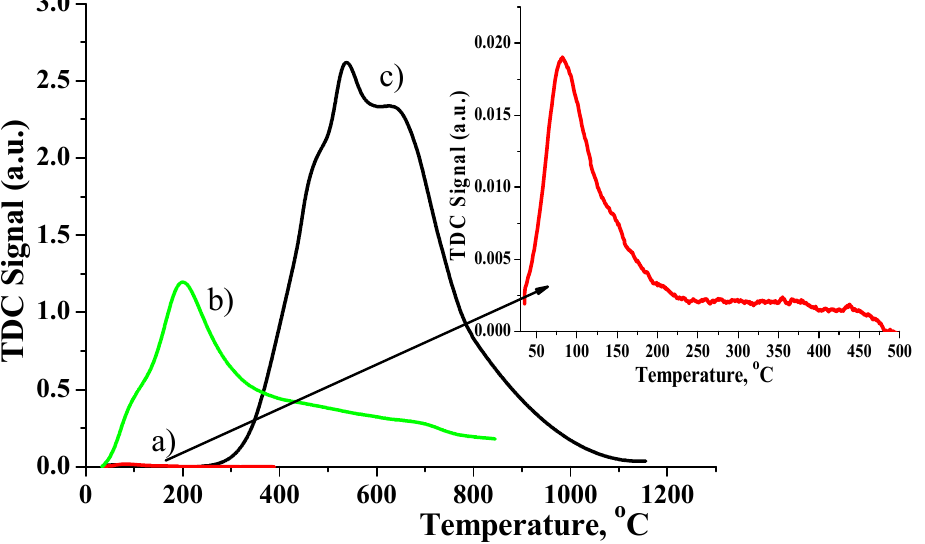
Figure 6. The acid properties of supports. The heating rate was 10 °C per minute. The composition of gas mixture is 3% NH 3 in He flow. ( a ) SiO 2 , ( b ) γ -Al 2 O 3 , ( c ) SiO 2 -C 3 H 6 -NH 2